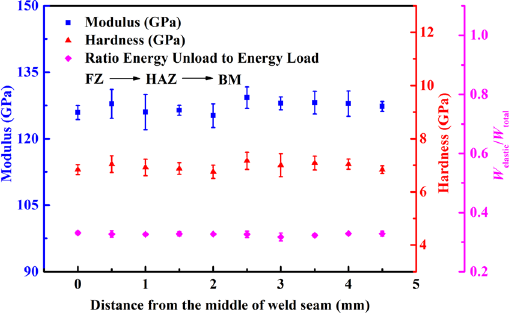
Figure 6. Indentation modulus, hardness and W elastic / W total , vs. the distance from the middle of weld seam, plot for the butt joint of Pd 43 Cu 27 Ni 10 P 20 bulk metallic glass obtained by the pulsed laser welding method.